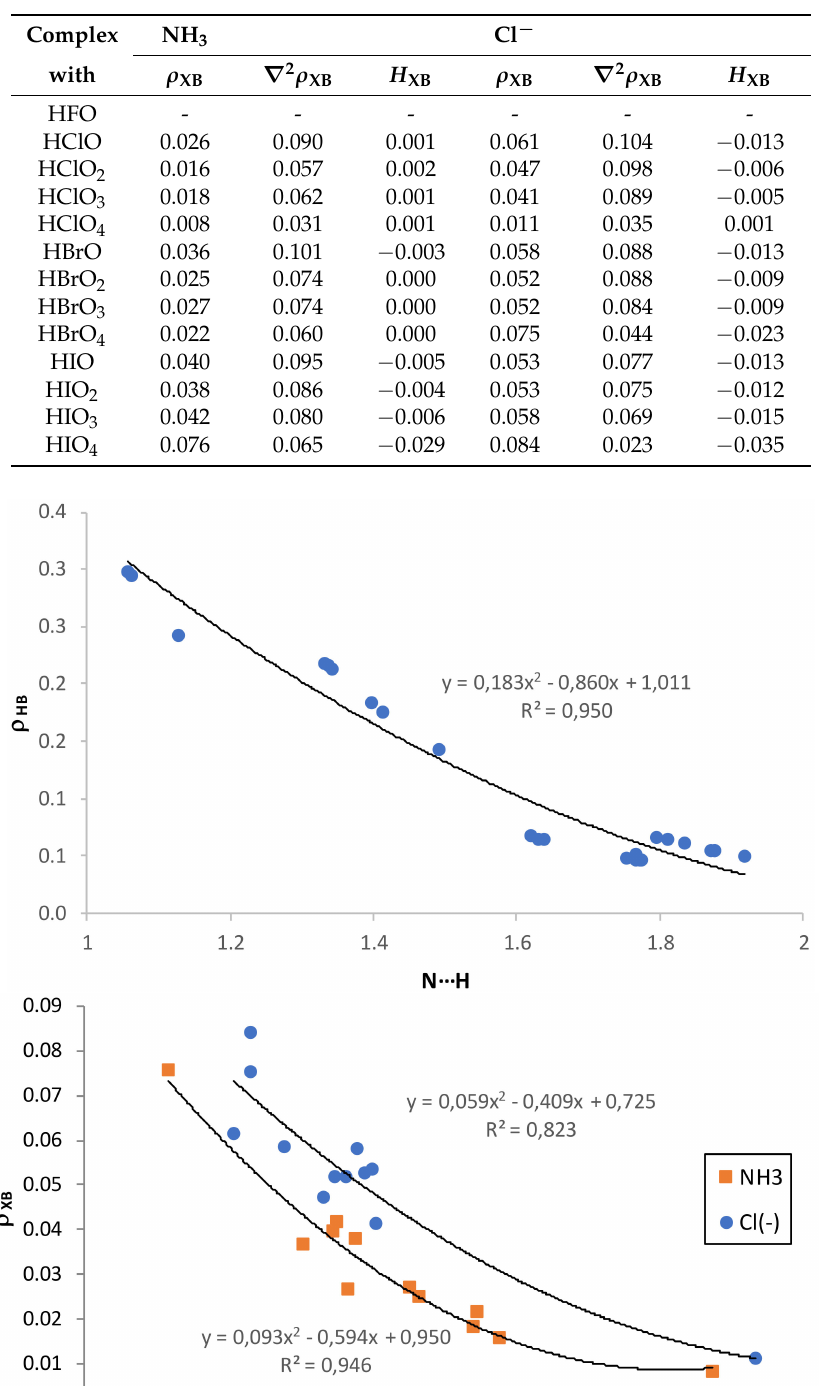
Table 6. Electron density ( ρ XB ), Laplacian ( ∇ 2 ρ XB ), and total electron density energy ( H XB ) in a.u. for the intermolecular bond critical points for XB complexes.